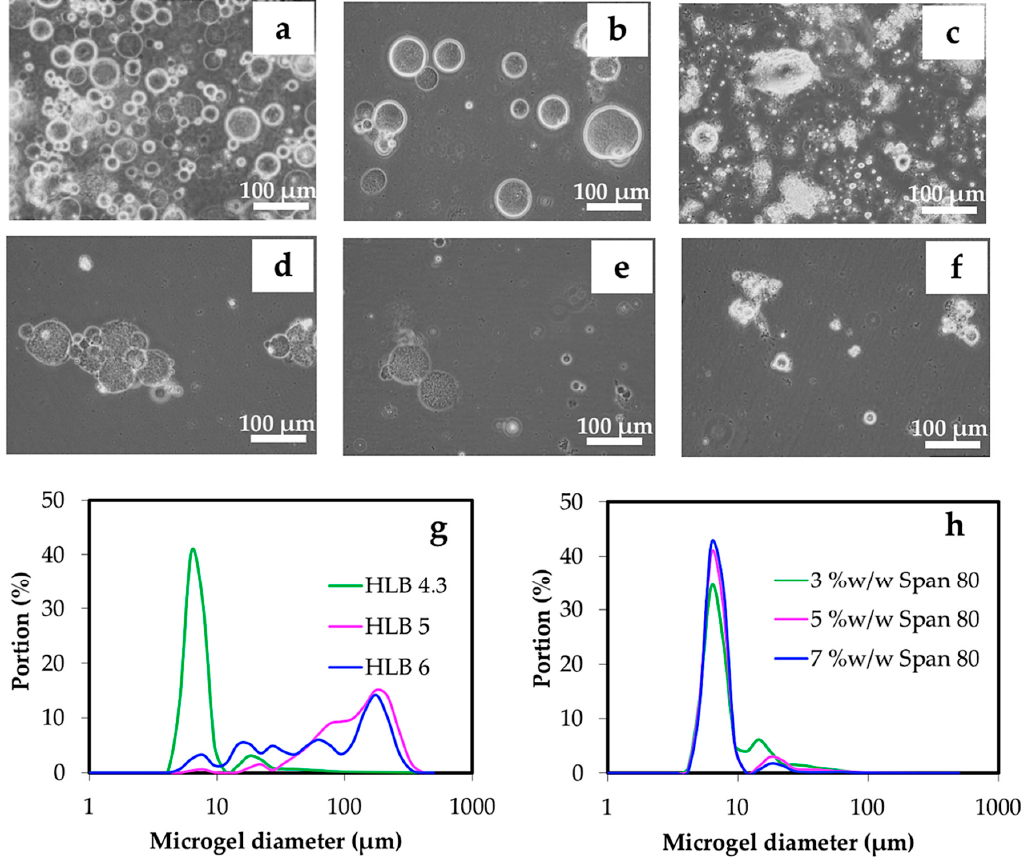
Figure 6. Optical microscopic images of microgels prepared from hydrophilic-lipophilic balance (HLB) values of surfactant at 4.3 ( a ), 5 ( b ), and 6 ( c ), and Span 80 at the concentrations of 3 % w / w ( d ), 5 % w / w ( e ), and 7 % w / w ( f ) by controlling the concentration of the chitin solution at 3 % w / w and an O:W ratio at 15:1. Gelation was carried out using 800 µ L of 1.0 M HCl. The representative size distributions of microgels prepared by different HLB values and Span 80 concentrations are shown in ( g ) and ( h ), respectively.